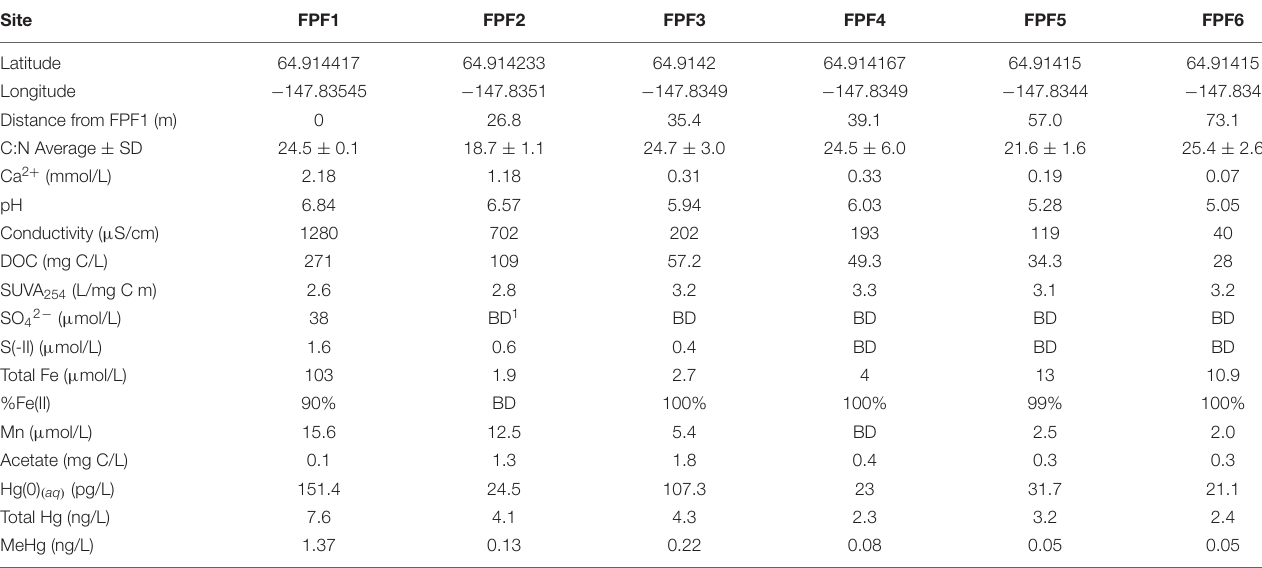
TABLE 1 | Sampling locations in Frozen Pond Fen (2016 and 2018) and filtered pore water geochemical data from 10 cm below the water table (2016). Site FPF1 FPF2